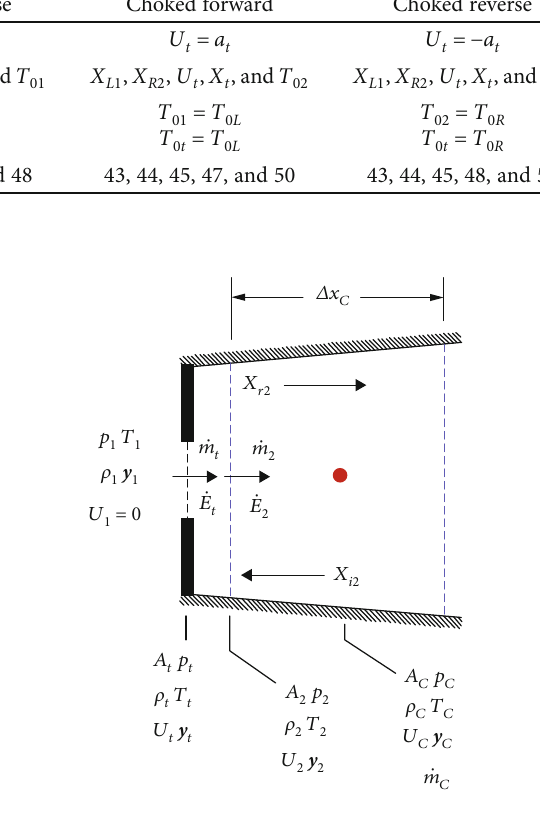
Figure 7: Schematic of 1D pipe boundary condition.